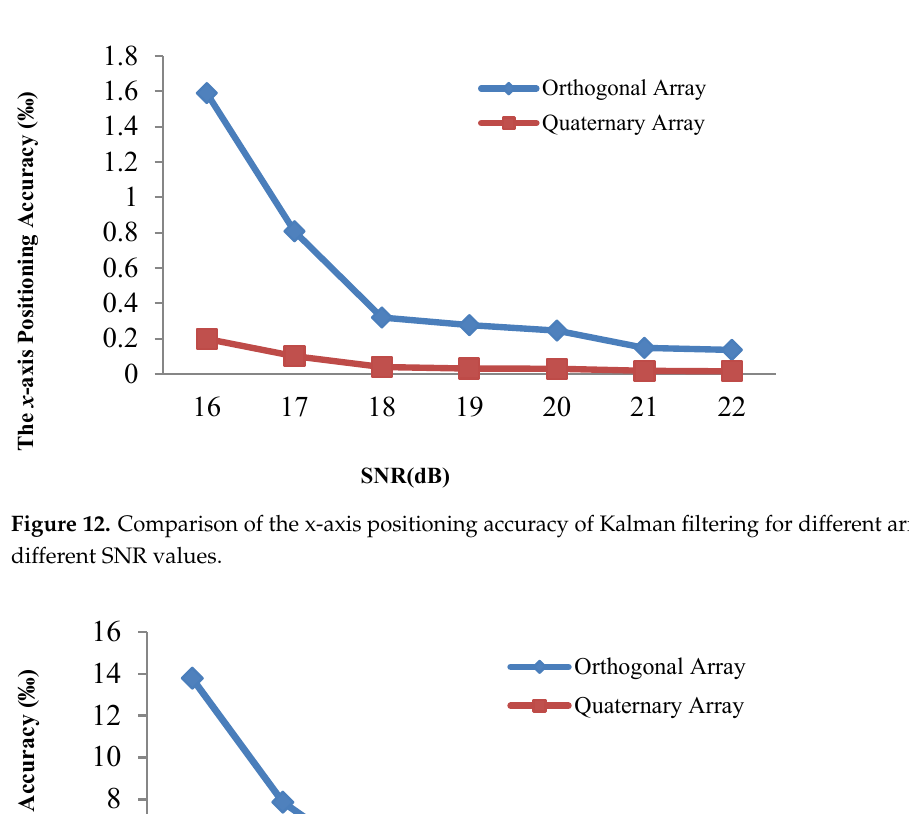
Figure 11. Comparison of the x-axis positioning accuracy of the adaptive algorithm for different arrays and different SNR values.